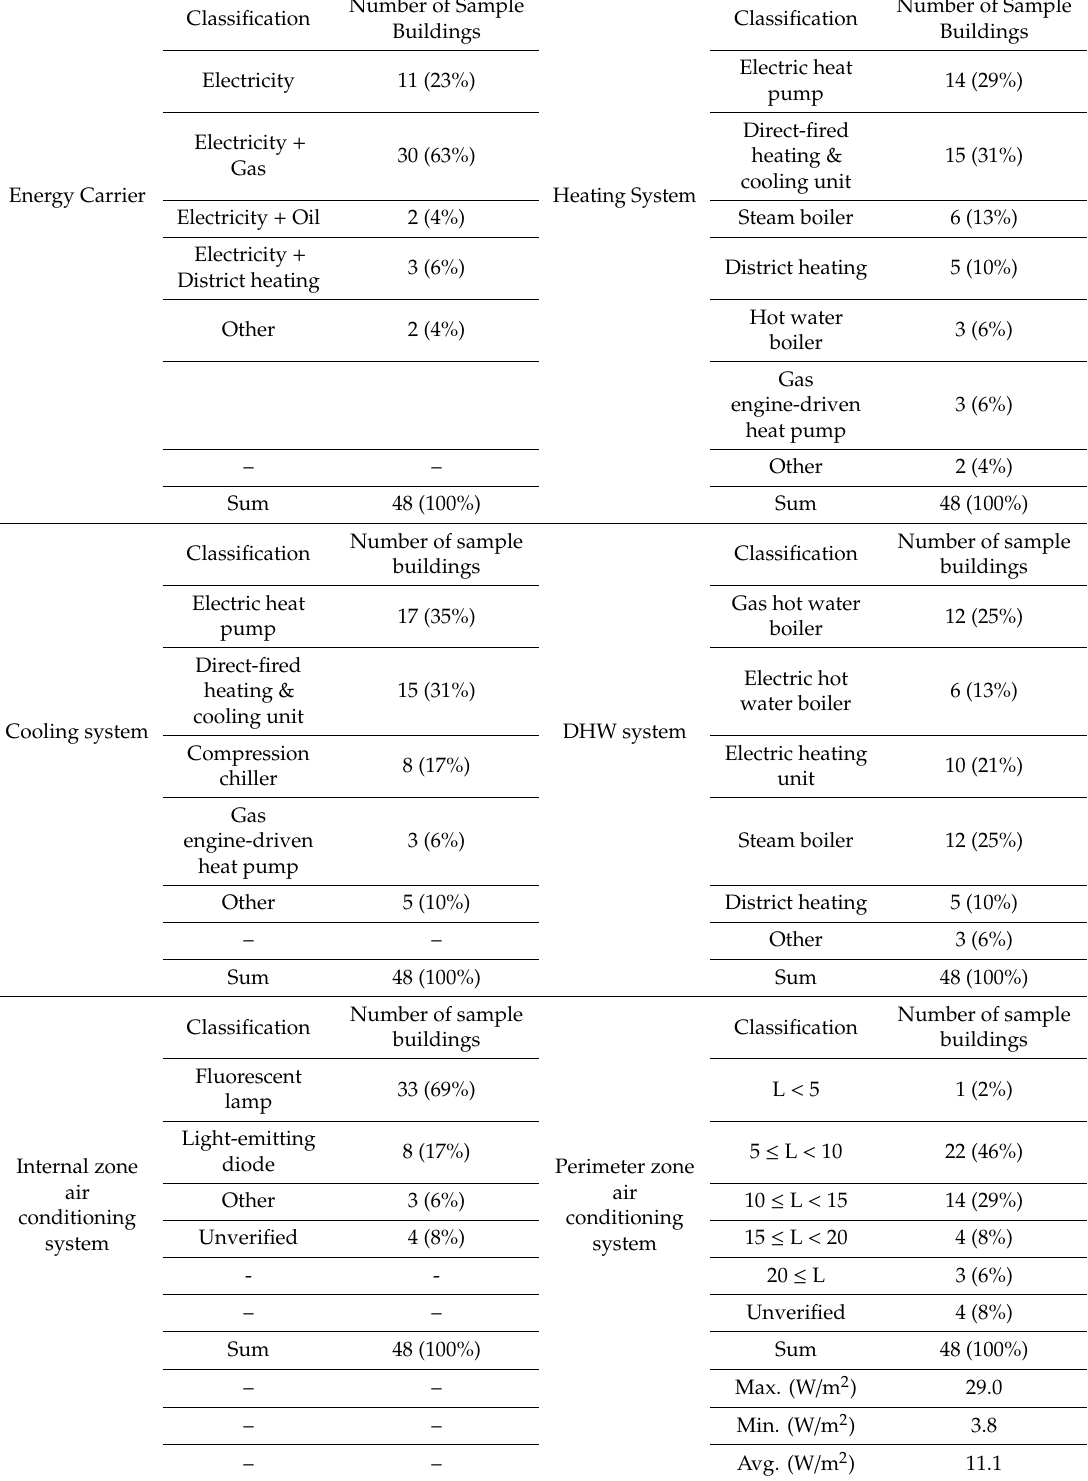
Table 7. Technical system